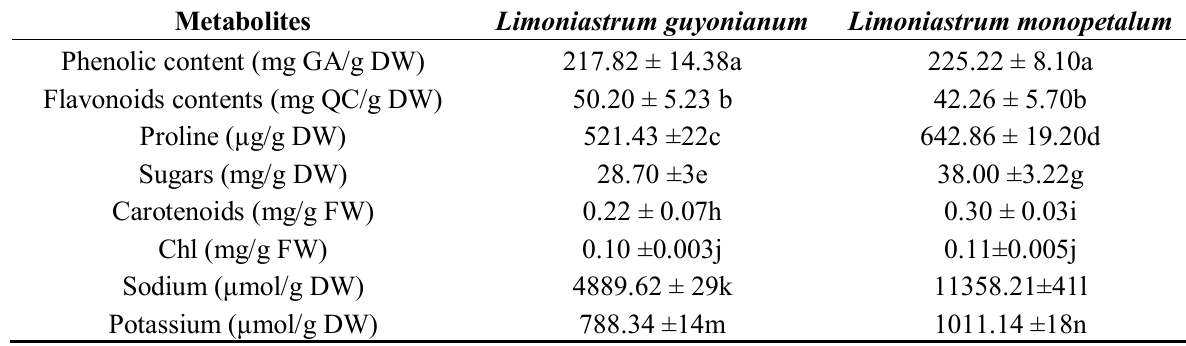
Table 2. Changes in metabolites contents in the leaves of Limoniastrum guyonianum and Limoniastrum monopetalum . Each data is the average of three replications ± SD. Means sharing at least one same letter are not significantly different according to Tukey test at p <